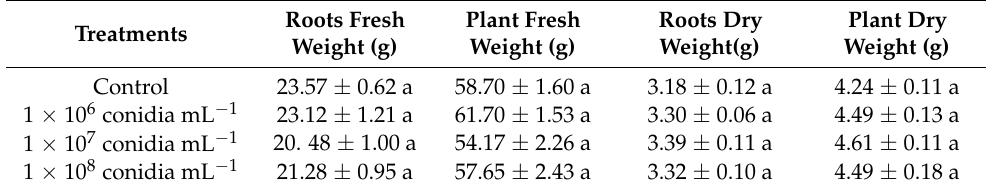
Table 3. The effect of Beauveria bassiana on dry and fresh weights of aerial part and roots of plants ( Lactuca sativa ) exposed to different conidial concentrations ( n = 120).